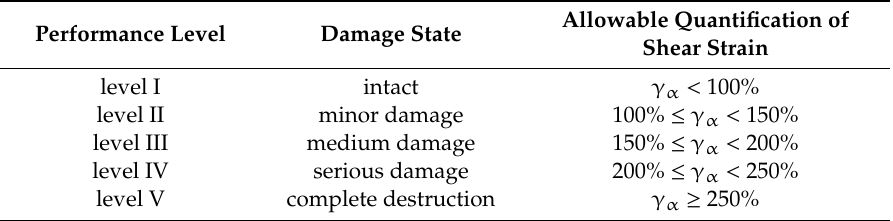
Table 5. Division of damage states of the bearings.